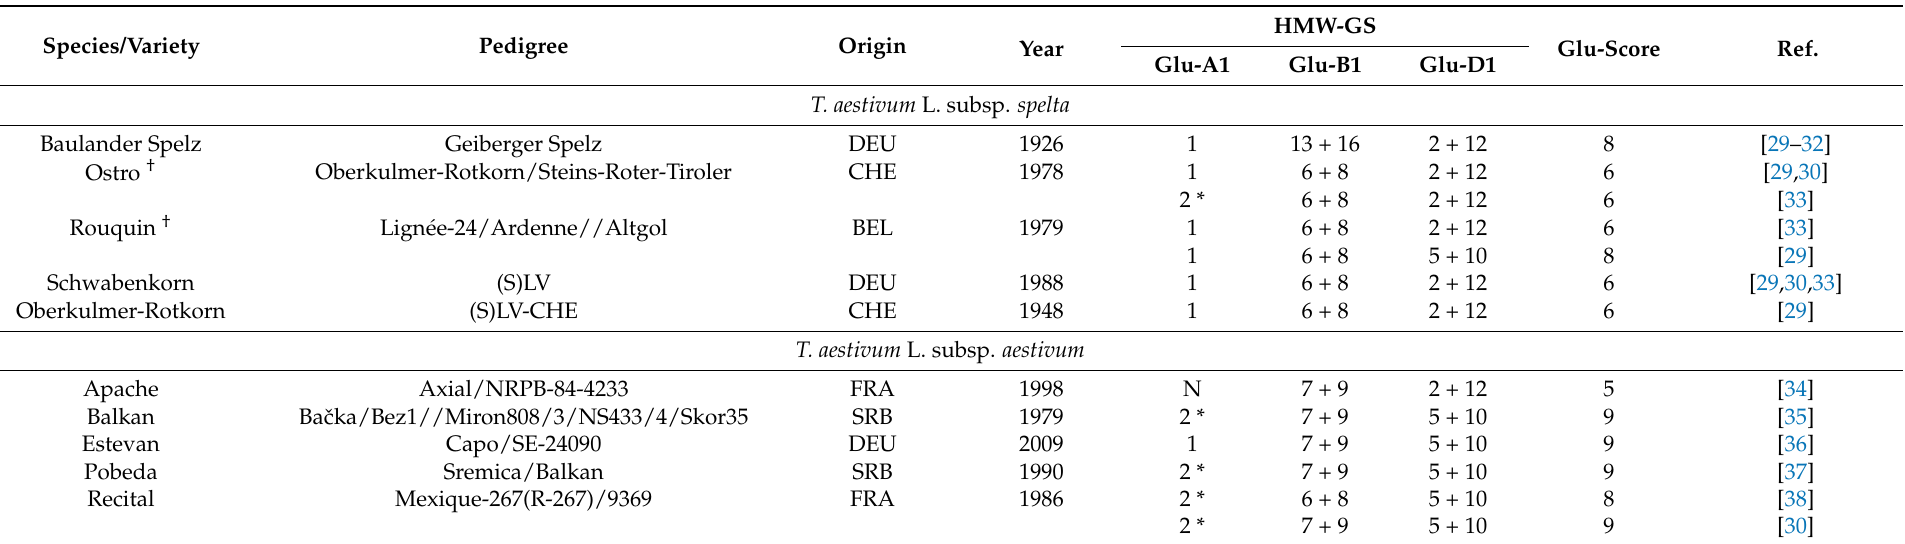
Table 1. List of analyzed spelt and bread wheat varieties, including the country of origin, the year of release, the high molecular weight glutenin subunits (HMW-GS) allelic composition and the Glu-scores according to the literature